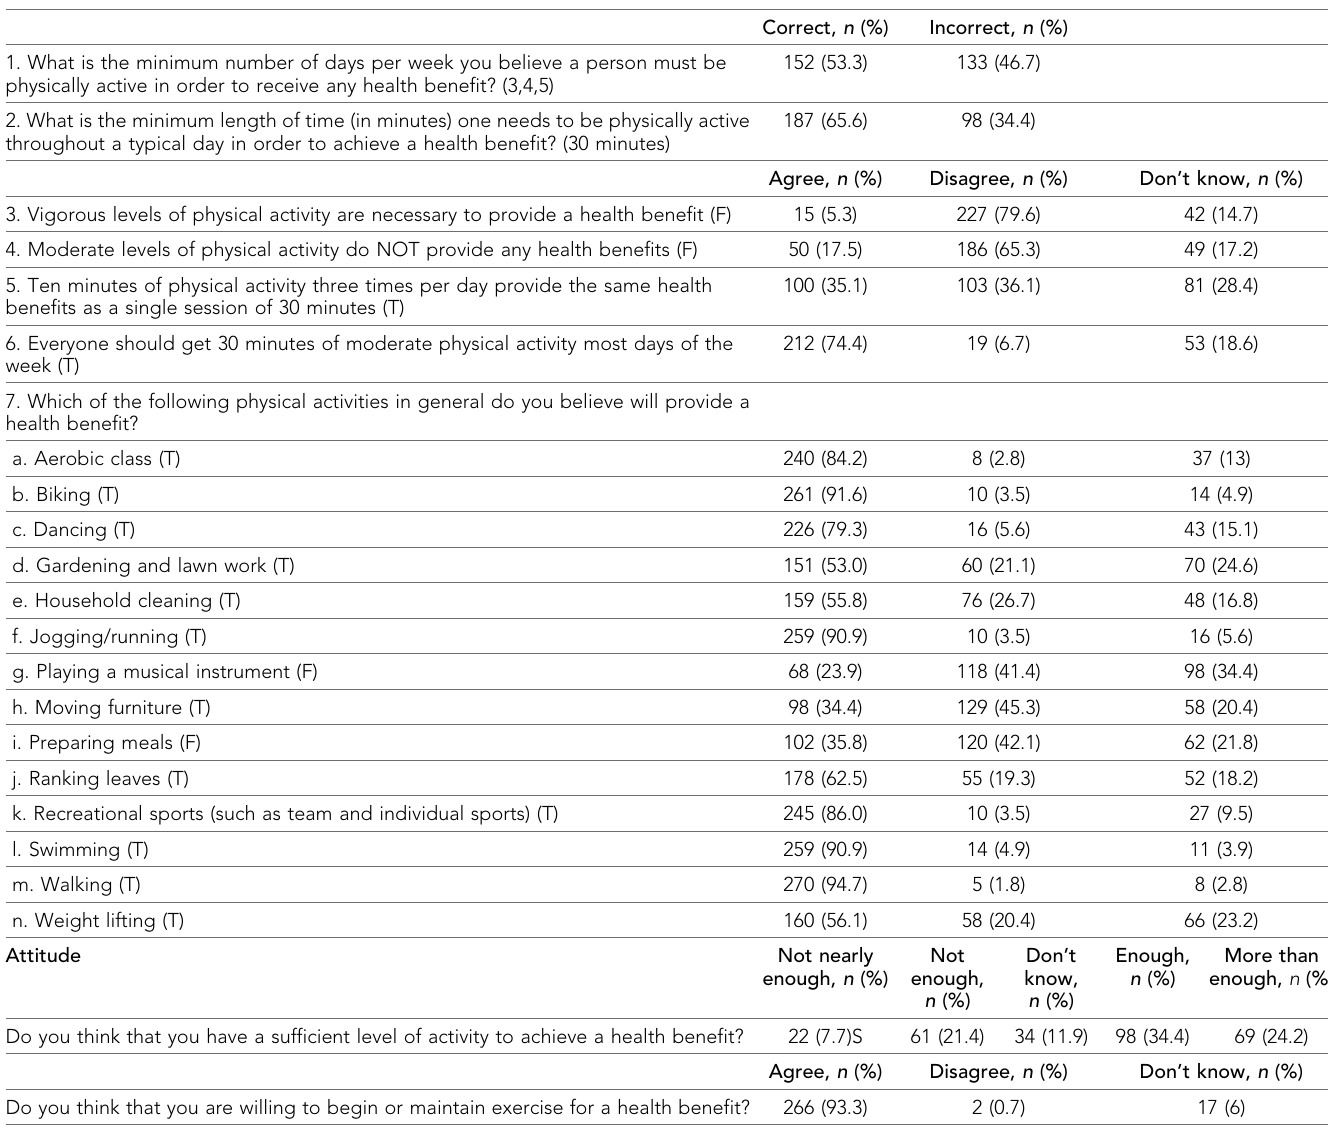
Table 3. Proportions of different answers in each PA knowledge